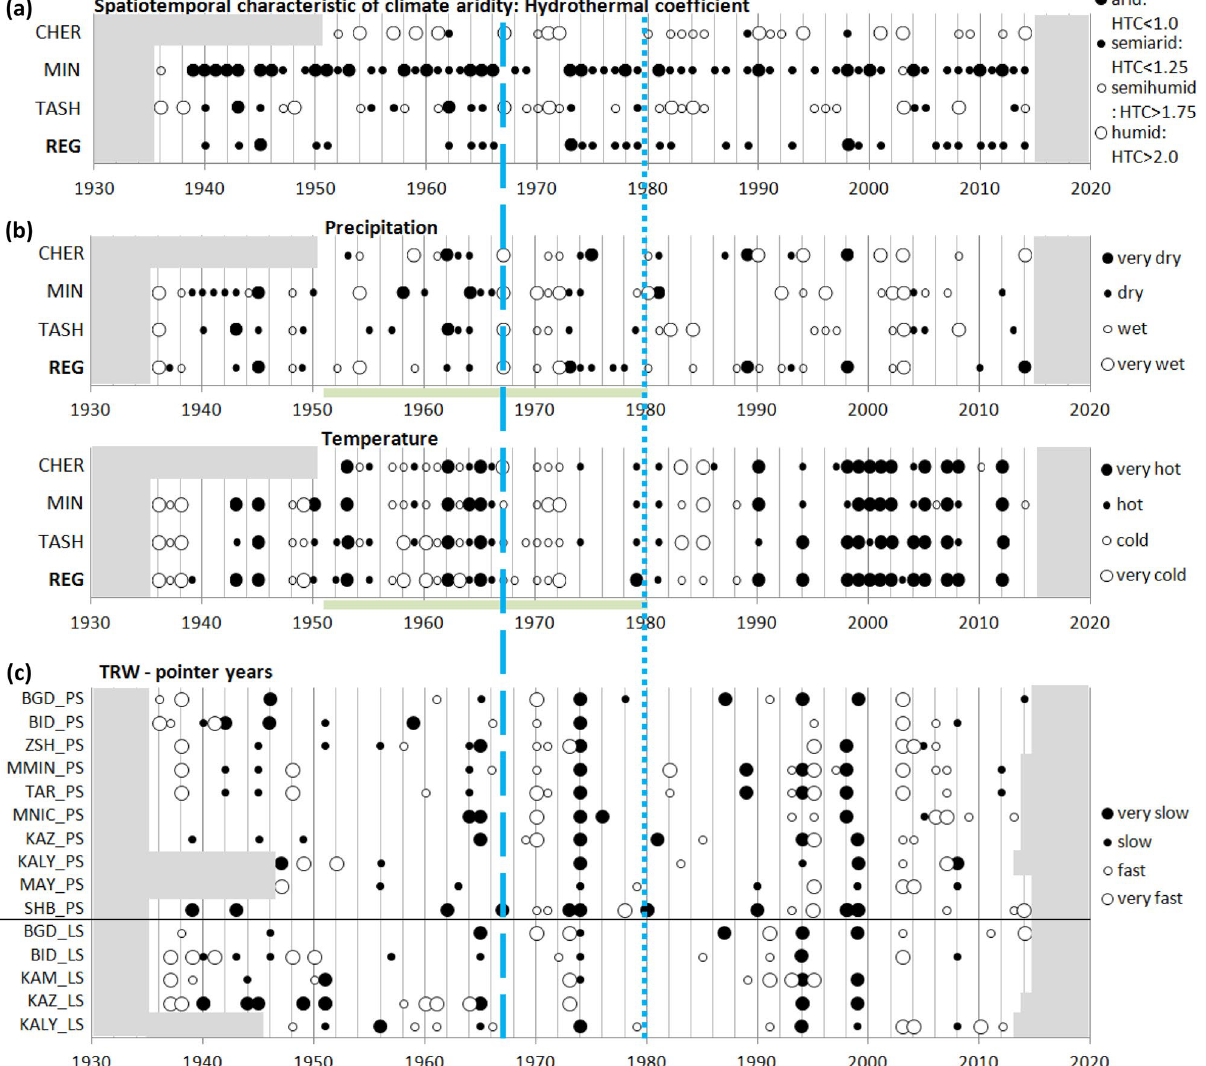
Figure 2. Dynamics of extremes in climatic variables and tree growth. ( a ) Climate aridity expressed as Selyaninov Hydrothermal coefficient HTC for May–September; ( b ) Extreme cold/hot and dry/wet years for May–September temperature T and precipitation P; ( c ) Pointer years indicated by extremes in TRW chronologies. Vertical lines mark launch of the turbines in dams of Krasnoyarsk Reservoir (dashed) and Sayano- Shushenskoe Reservoir